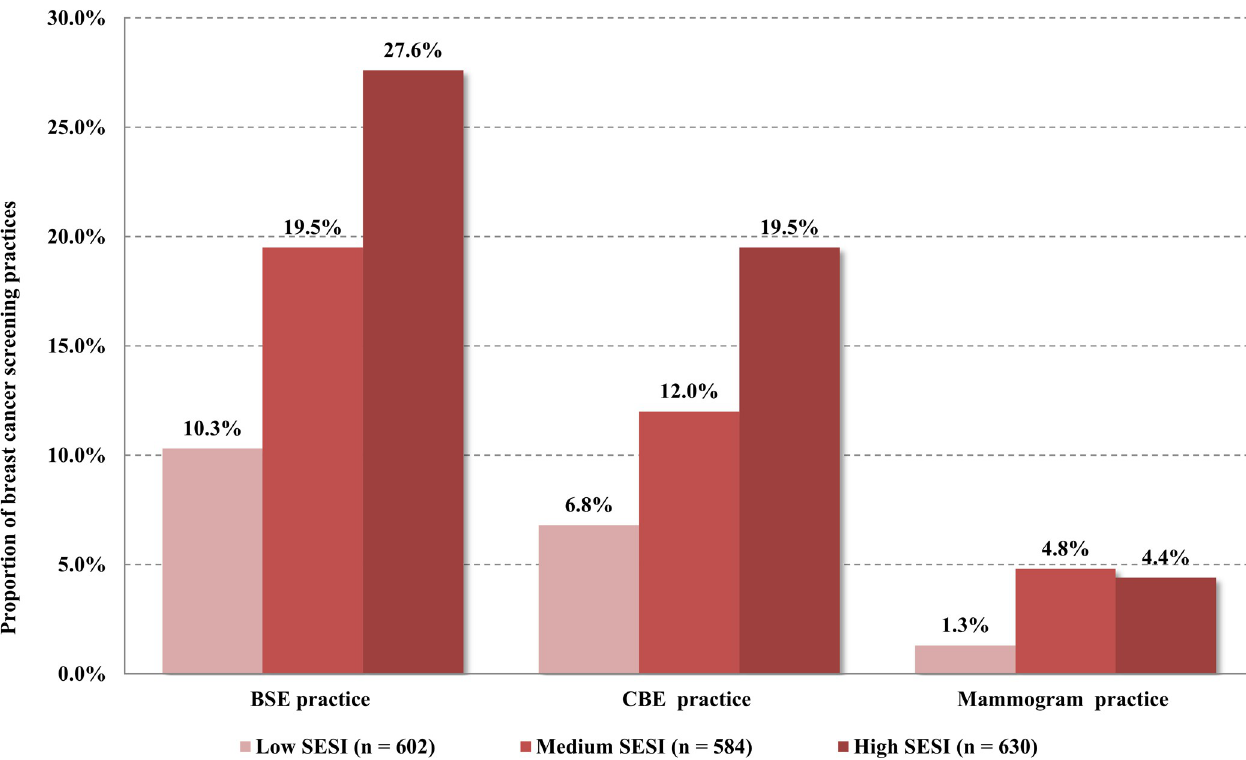
Fig 1. Proportion of breast cancer screening practices (n = 1816). BSE, breast self-examination; CBE, clinical breast examination; SESI, socioeconomic status index.